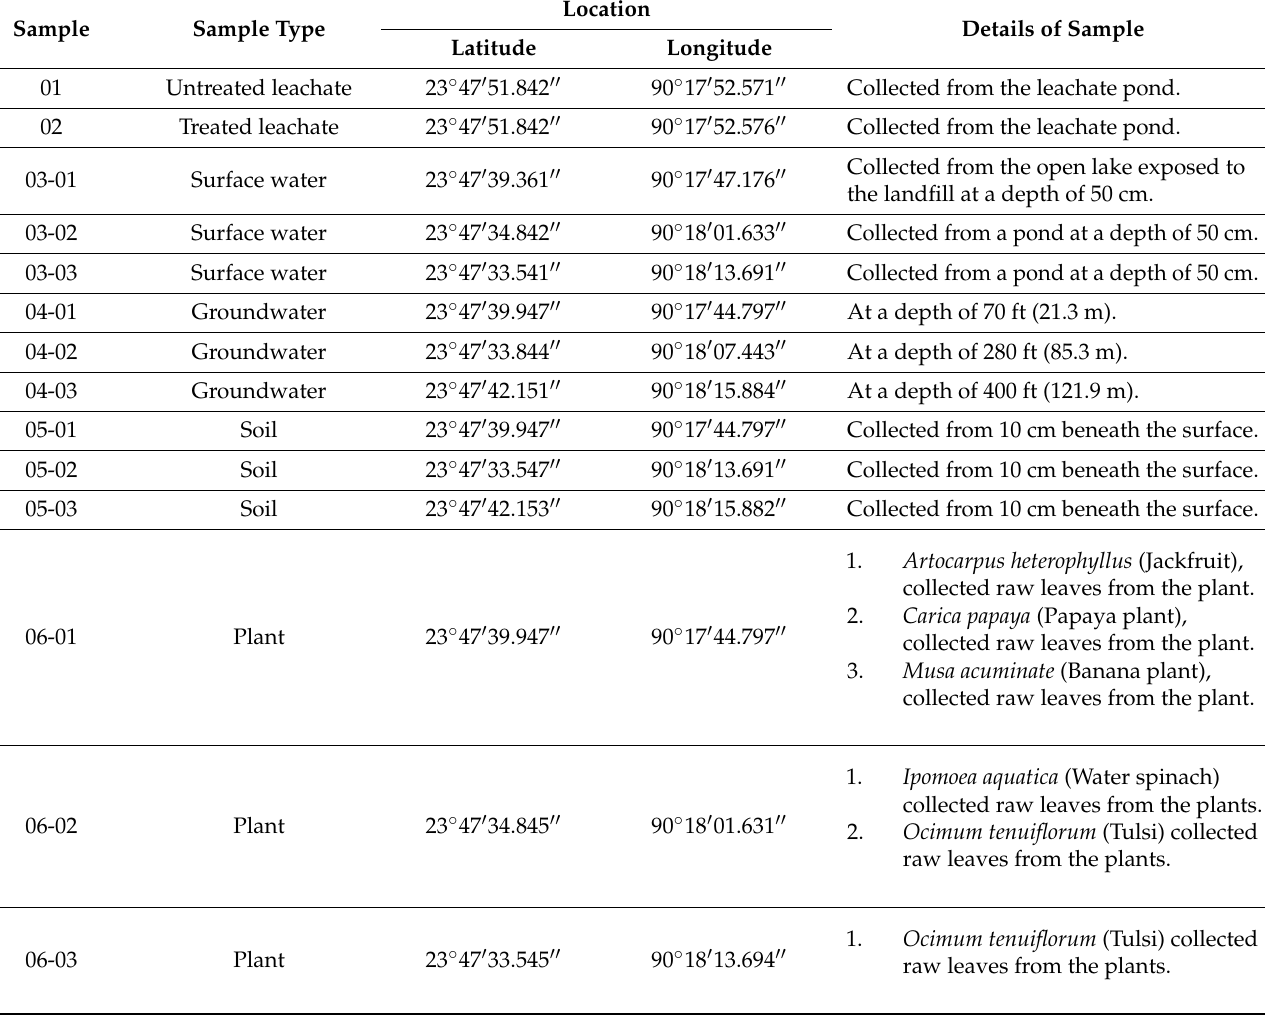
Table 1. Details of collected